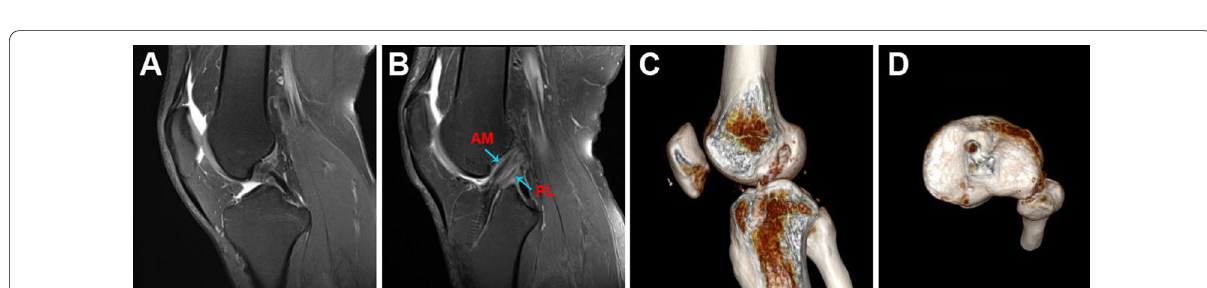
Fig. 6 Radiological examination of STDB ACL reconstruction. A Preoperative MRI showed ACL rupture. B MRI at the last follow-up showed complete graft healing. C 3D CT showed the femoral socket and the tibial tunnel. D 3D CT showed the tibial socket